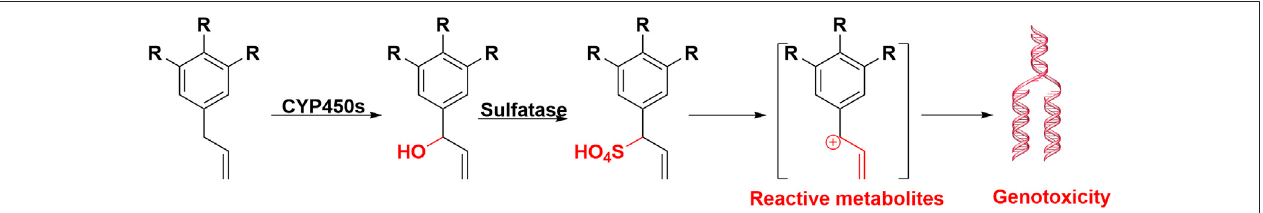
FIGURE 5 | Metabolic activation of alkenylbenzenes induced carcinogenicity. After hydroxylation and solidi fi cation, alkenylbenzenes were formed carbocation intermediate, at last produced DNA adducts, and led to carcinogenicity.